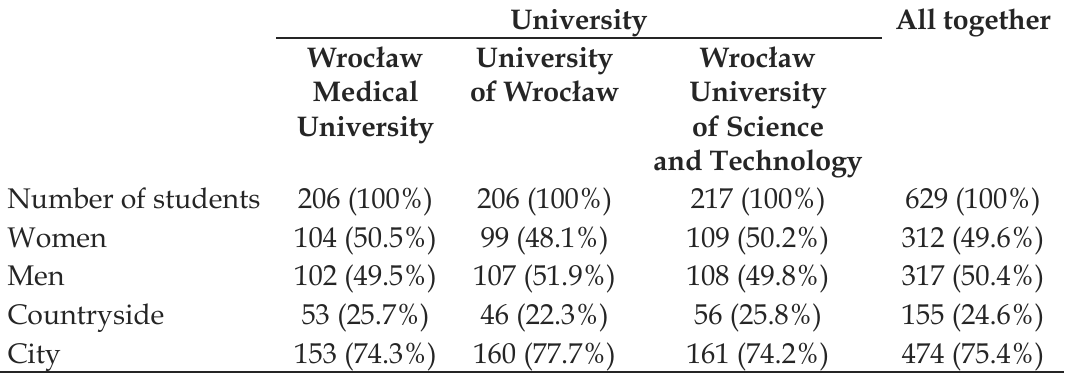
Characteristics of the tested group University All together Wroc (cid:227)